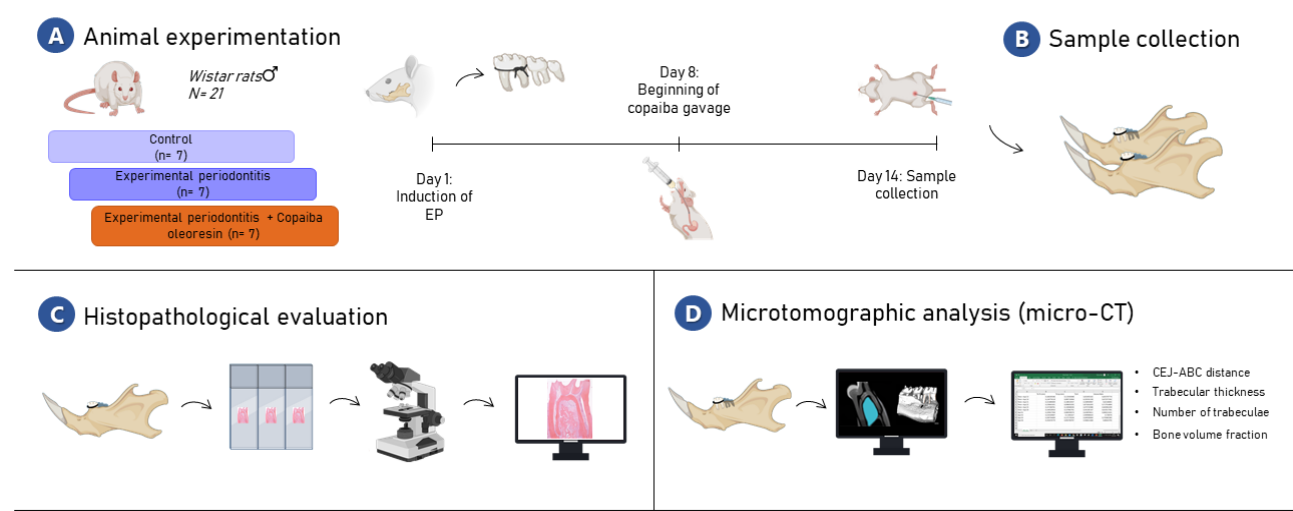
Figure 7. The methodological figure of the experimental steps. In ( A ), the experimental stages of the study are displayed; In ( B ), the sample collection stage is represented; In ( C ), the histopathological evaluation is represented by the light field microscopy schematic figure; In ( D ), the microtomo- graphic analysis (micro-CT) is displayed. This figure was created with BioRender.com, accessed on 25 July